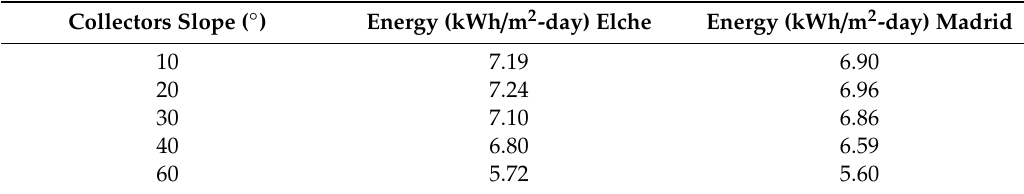
Table 2. Average daily radiation received per square meter of inclined collector surface. Collectors Slope ( ◦